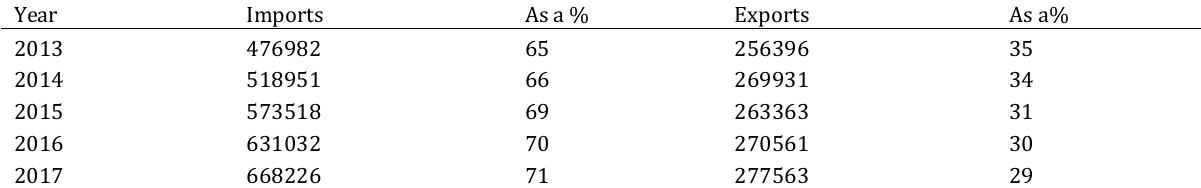
Table 1: The trend of import and export volumes in Sri Lanka in TEUs Year Imports As a % Exports As a% 2013